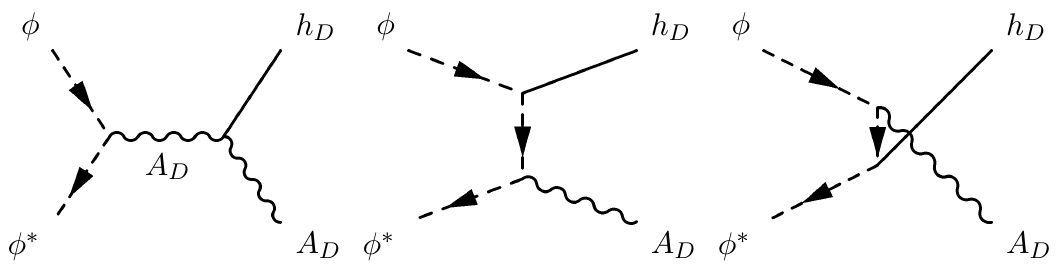
Figure 3. The Feynman diagrams which contribute to the φ